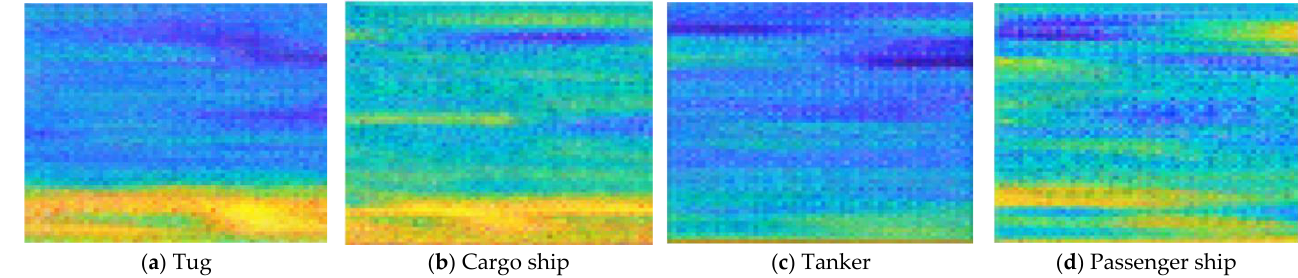
Figure 15. DCGAN model generation samples of different types of ships.